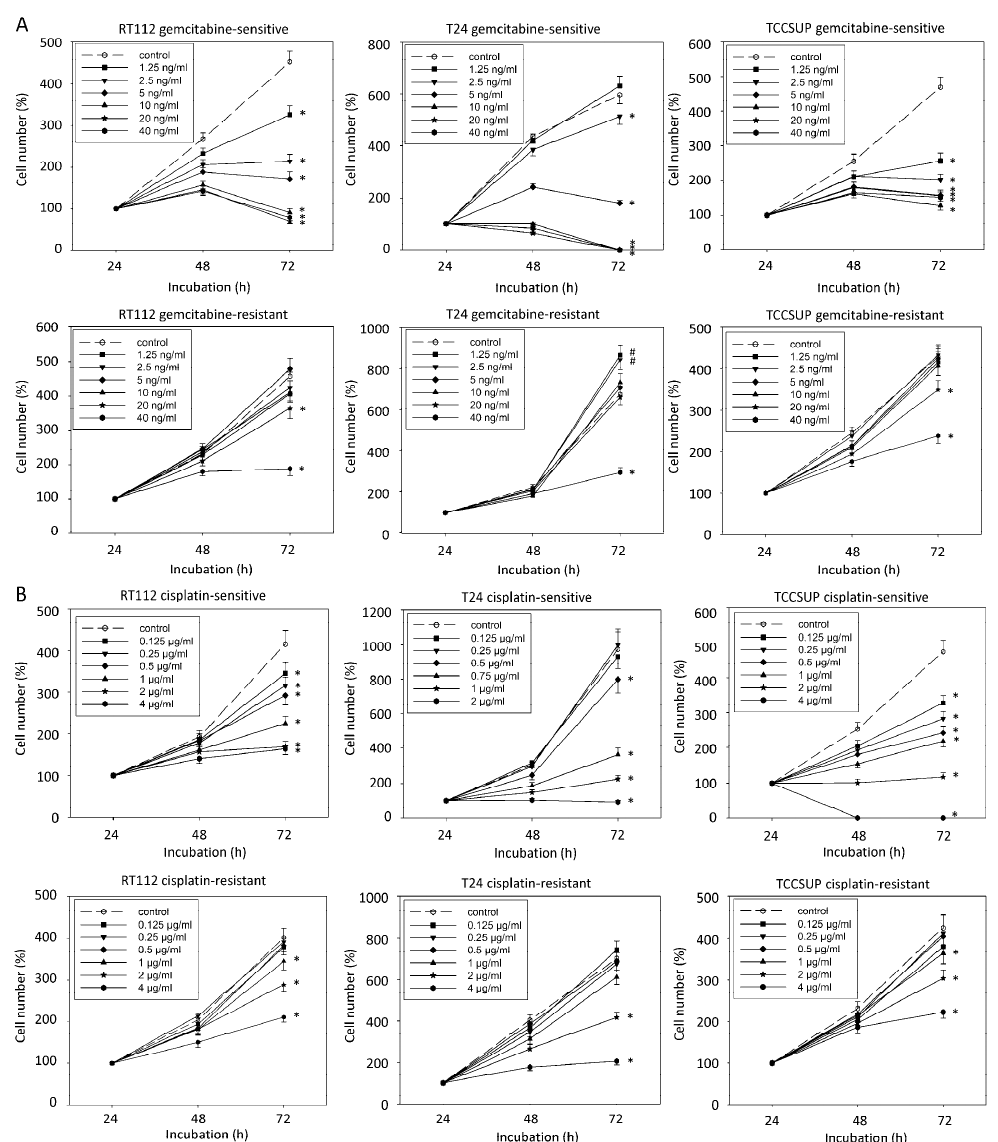
Figure 2. Growth blocking effects of increasing concentrations of gemcitabine (up: sensitive cells, down: resistant cells), ( A ), and cisplatin (up: sensitive cells, down: resistant cells), ( B ). Cell number was evaluated after 24, 48, and 72 h by the MTT assay, whereby 24 h values were set to 100%. Error bars indicate standard deviation. Experiments were repeated five times. One representative experiment is shown. * indicates significant down-regulation, # indicates significant up-regulation to the untreated control, n =